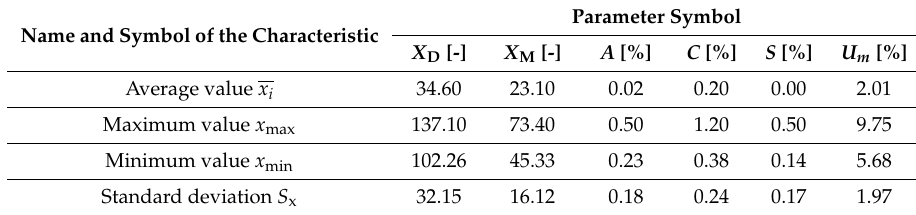
Table 3 summarizes selected statistical characteristics of the obtained test results. Table 3. List of selected statistical characteristics of